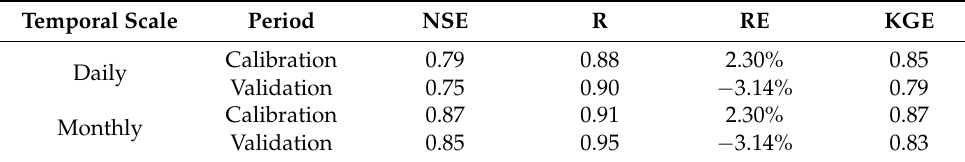
Figure 7. A comparison between the observed and simulated multi-year average monthly discharge in the calibration ( a ) and validation ( b ) periods. in the calibration ( a ) and validation ( b ) periods. Table 3. The calibration and validation results of the SWAT Table 3. The calibration and validation results of the SWAT model.